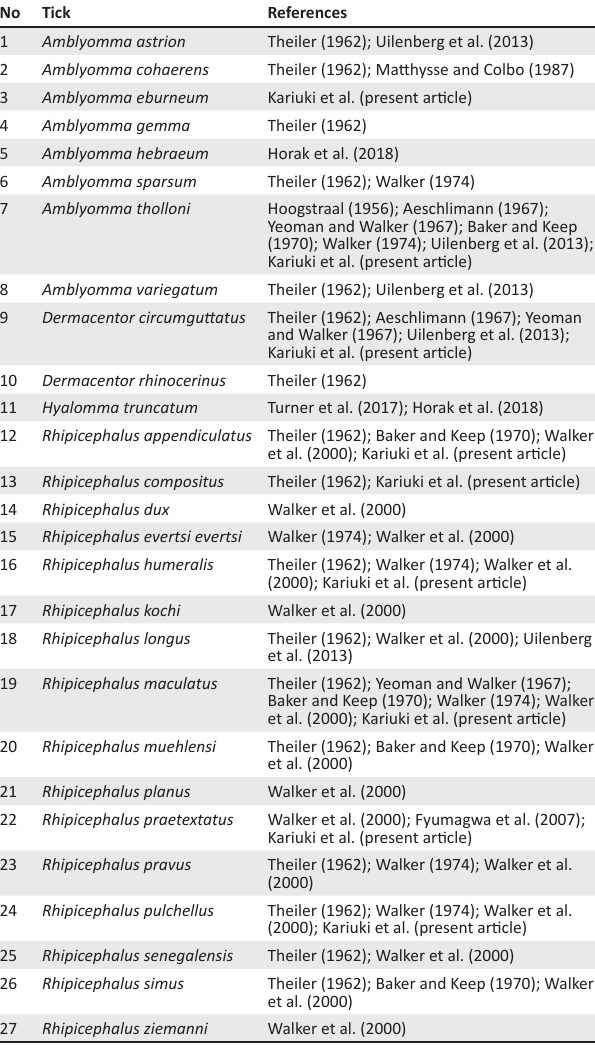
TABLE 3: Annotated checklist of the tick species collected from African elephants. TABLE 2: Ticks collected from African elephants (1905–1980) and deposited in